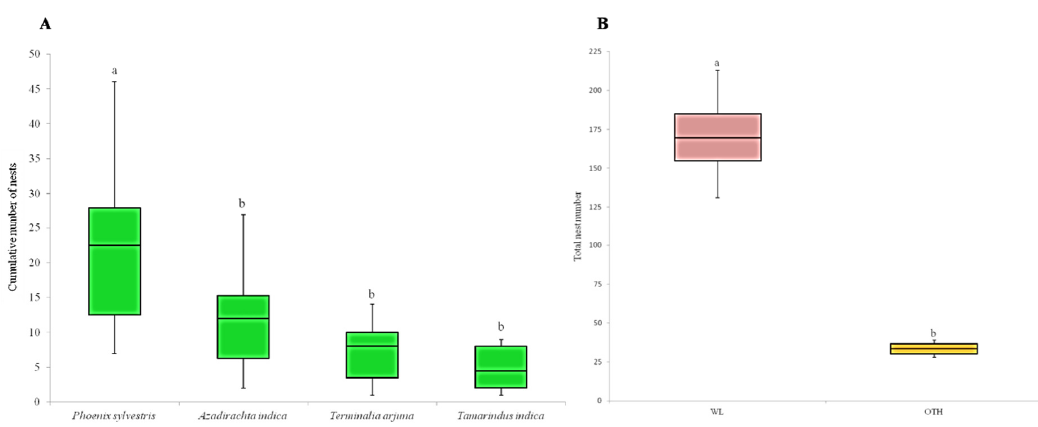
Figure 5. Box plots representing A. Tree-wise cumulative nest number and B. Habitat-wise total nest number recorded during the present study in four tree species Each box plot shows minimum, lower quartile, median, upper quartile, and maximum values. Mean values were compared using one-way ANOVA with pair-wise comparisons made with Tukey's HSD (honestly significant difference) tests. Nest number recorded in four trees: Phoenix sylvestris , n=273; Azadirachta indica , n=134; Terminalia arjuna , n=85 and Tamarindus indica , n=59. Groups not sharing lowercase letters are significantly different (Tukey’s HSD test, p < 0.01). WL=Wetland associated habitats, OTH=Other habitats.